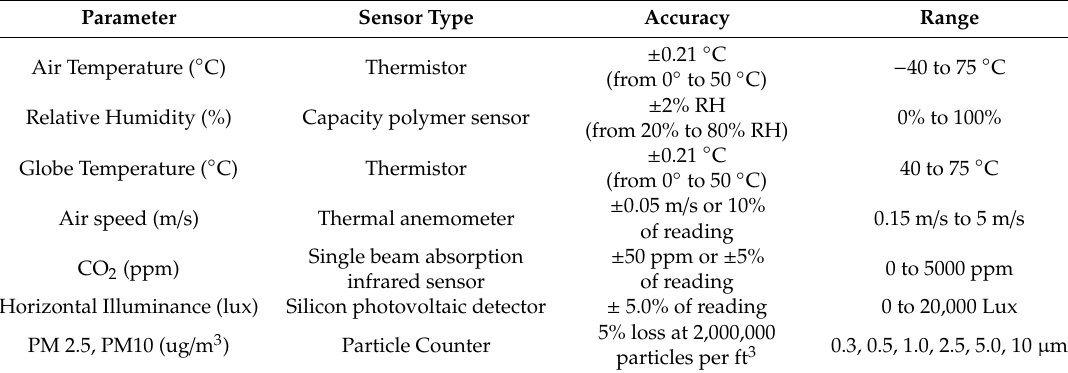
Figure 3. Custom-Built Continuous IEQ Monitoring Station, Desktop Type. Table 5. Specifications of IEQ Measurement